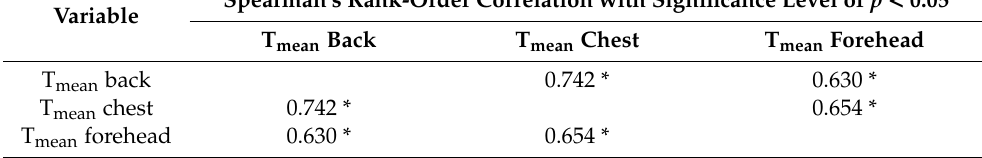
Table 3. The results of Spearman’s rank-order correlation analysis of the T mean temperatures under